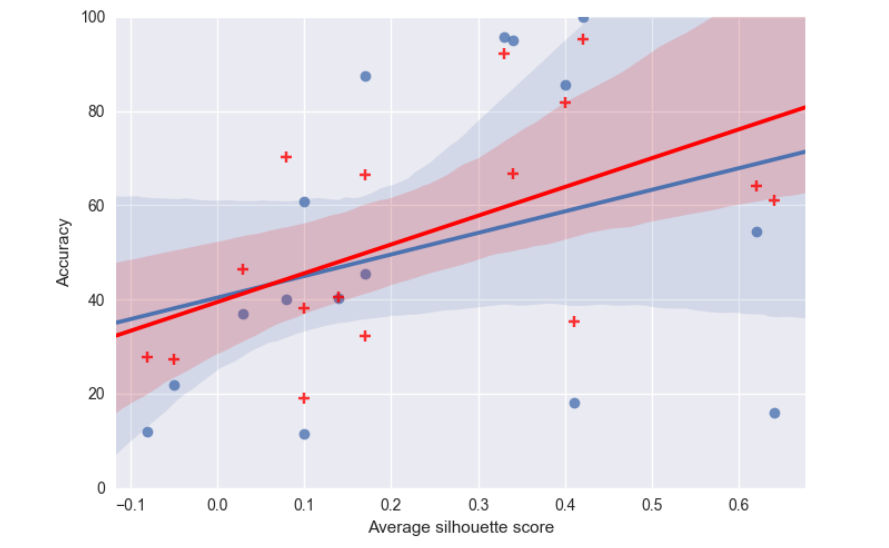
Figure 7. Relationship between the silhouette estimated after applying the T-SNE technique to the training set and the accuracy measures estimated (see accuracy definitions in Section 5.2). Blue points and the blue line are related to the notification accuracy and the red crosses and red line are related to the test